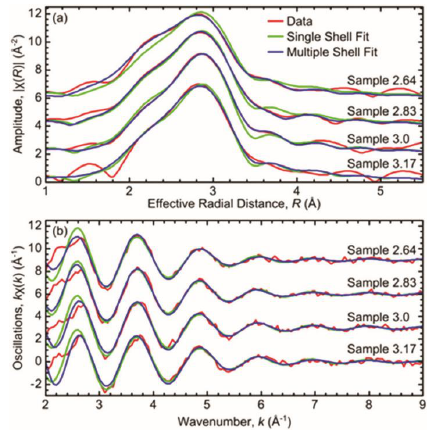
Figure 7. EXAFS spectra and fits in ( a ) R-space and ( b ) k-space for all samples. The figure was taken from Reference [51] with